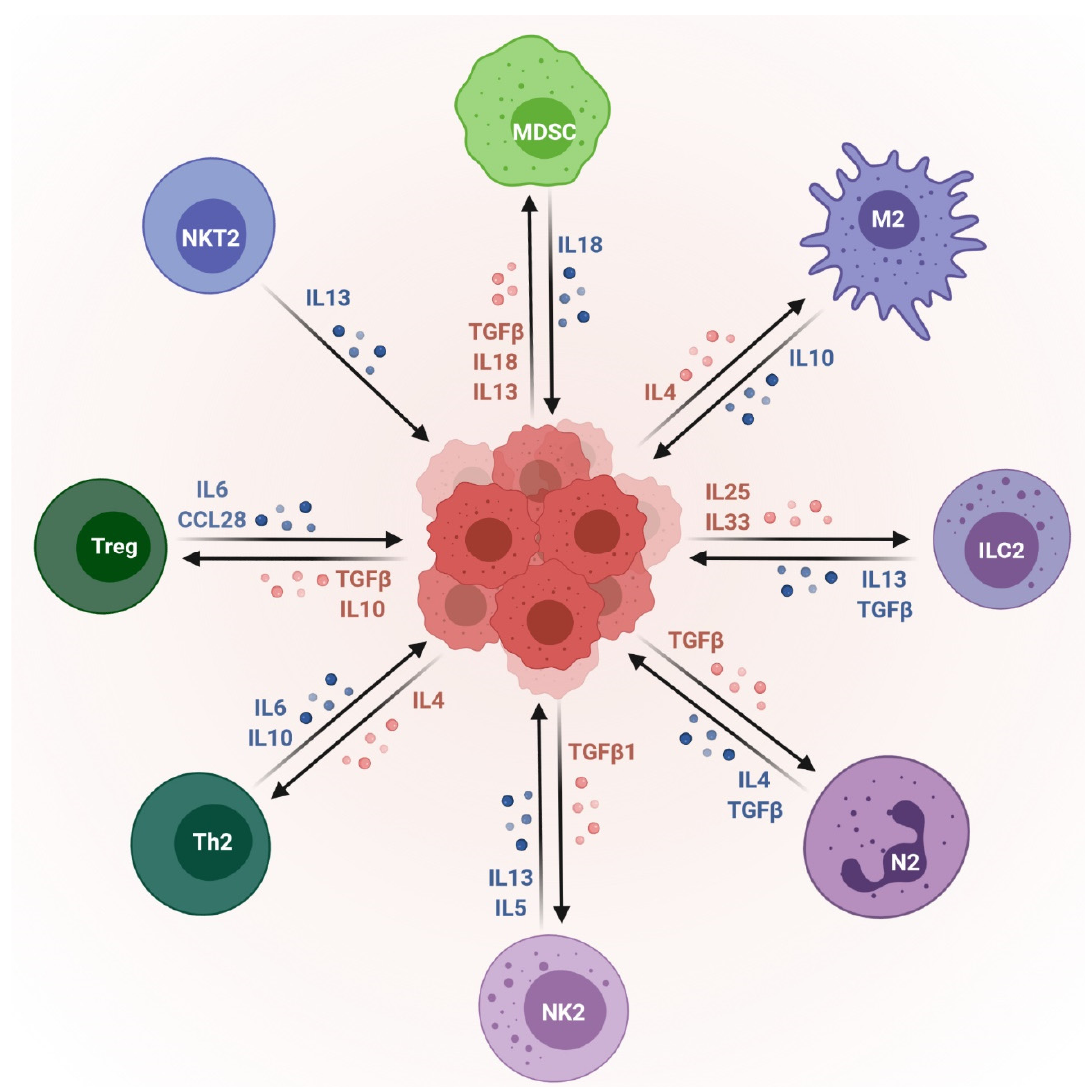
Figure 1. Immunosuppressive cells in the tumor microenvironment. The immunosuppressive component of the tumor microenvironment’s bidirectional interactions with tumor cells. Myeloid-derived suppressor cells (MDSC); anti-inflammatory macrophages (M2); group 2 innate lymphoid cells (ILC2); neuro-2 (N2); natural killer 2 (NK2); type 2 T helper (Th2); regulatory T cells (Treg); type 2 natural killer T (NKT2). This image was created using BioRender (http://biorender.com/ accessed on 10 August 2021).